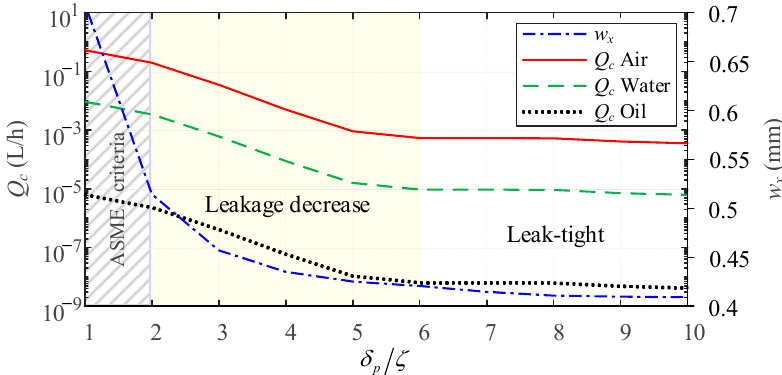
Figure 18. Leakage ratios as a function of rate δ p / ζ .